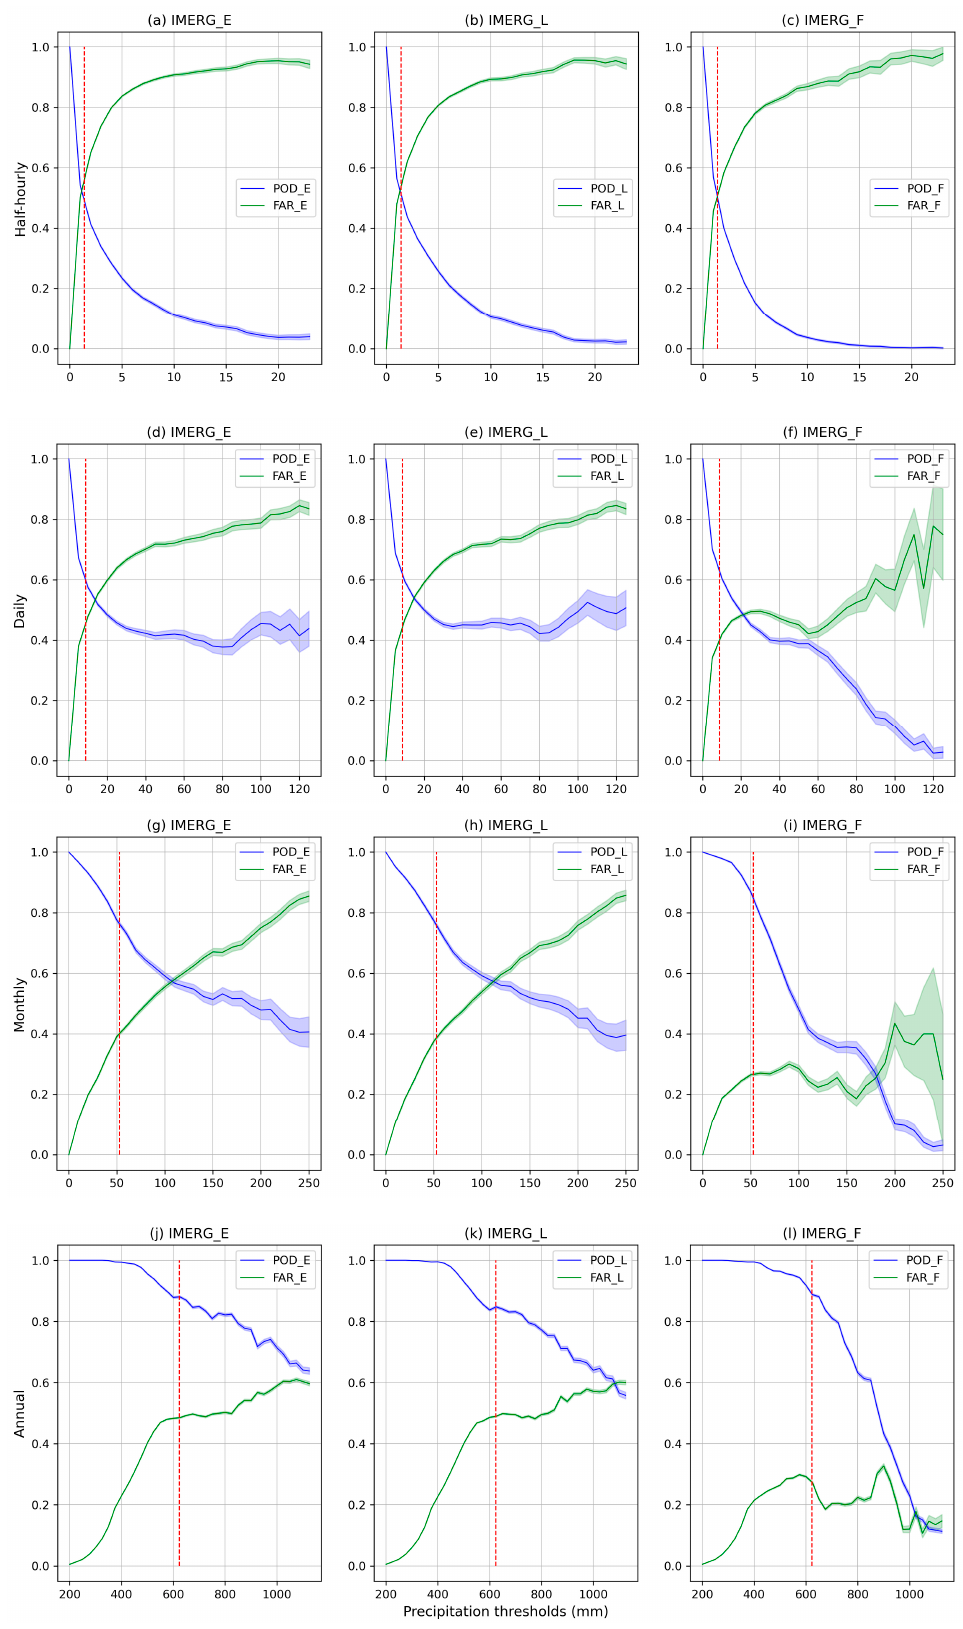
Figure 7. POD , FAR and errors associated at different time scales and precipitation thresholds. The vertical dashed red line represents the mean of the observations at each time scale.